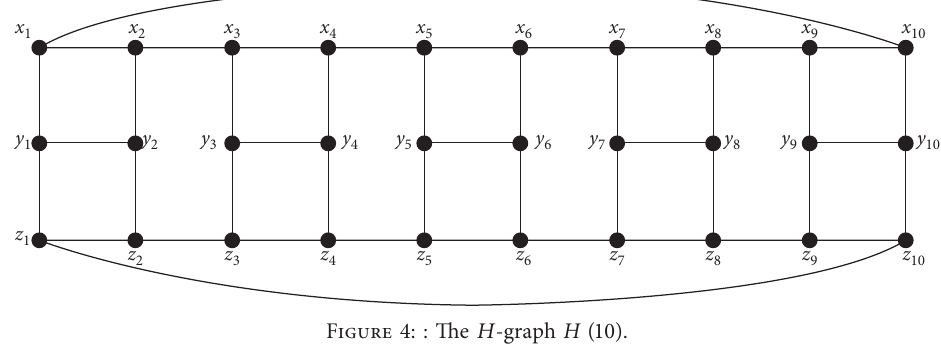
Figure 4: : The H -graph H